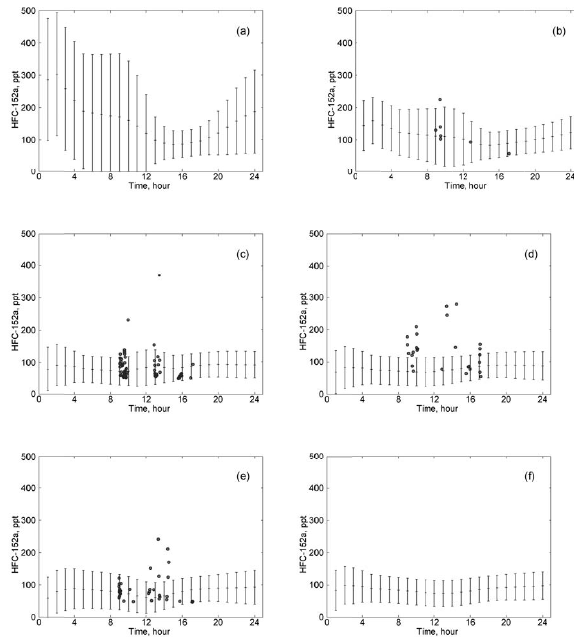
Fig. 9. The mean concentration and 1- σ values of HFC-152a at Figure 9: The mean concentration and 1- σ values of HFC-152a at different vertical layers in different vertical layers in the cells comprising the SoCAB, as cal- culated by the UCI-CIT model using the 9 September 1993 meteo- the cells comprising the SoCAB, as calculated by the UCI-CIT model using the September 9, rological data set and land-use data from the USGS. The mean con- 1993 meteorological data set and land-use data from the USGS. The mean concentration in centration in the (a) lowest layer, (b) second layer, (c) third layer, the (a) lowest layer, (b) second layer, (c) third layer, (d) fourth layer, and (e) highest layer are (d) fourth layer, and (e) highest layer are calculated using Eq. (4) in the Supplement. The average concentration over all vertical lay- ers in the SoCAB (f) is calculated using Eq. (3) in the Supplement. Measurements from the ARCTAS-CARB flights are shown as solid black dots. No measurements were collected in the lowest